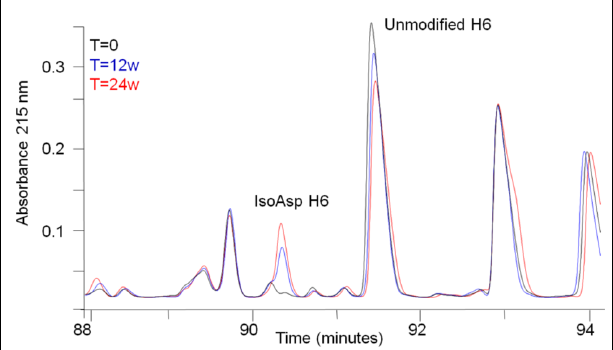
FIGURE 1 | Peptide map analysis of stability samples. Selected region of tryptic peptide maps of a stability sample held at 40 ◦ C for 0 weeks (black), 12 weeks (blue), or 24 weeks (red).The peptide corresponding to isoAsp H6 and unmodified H6 are